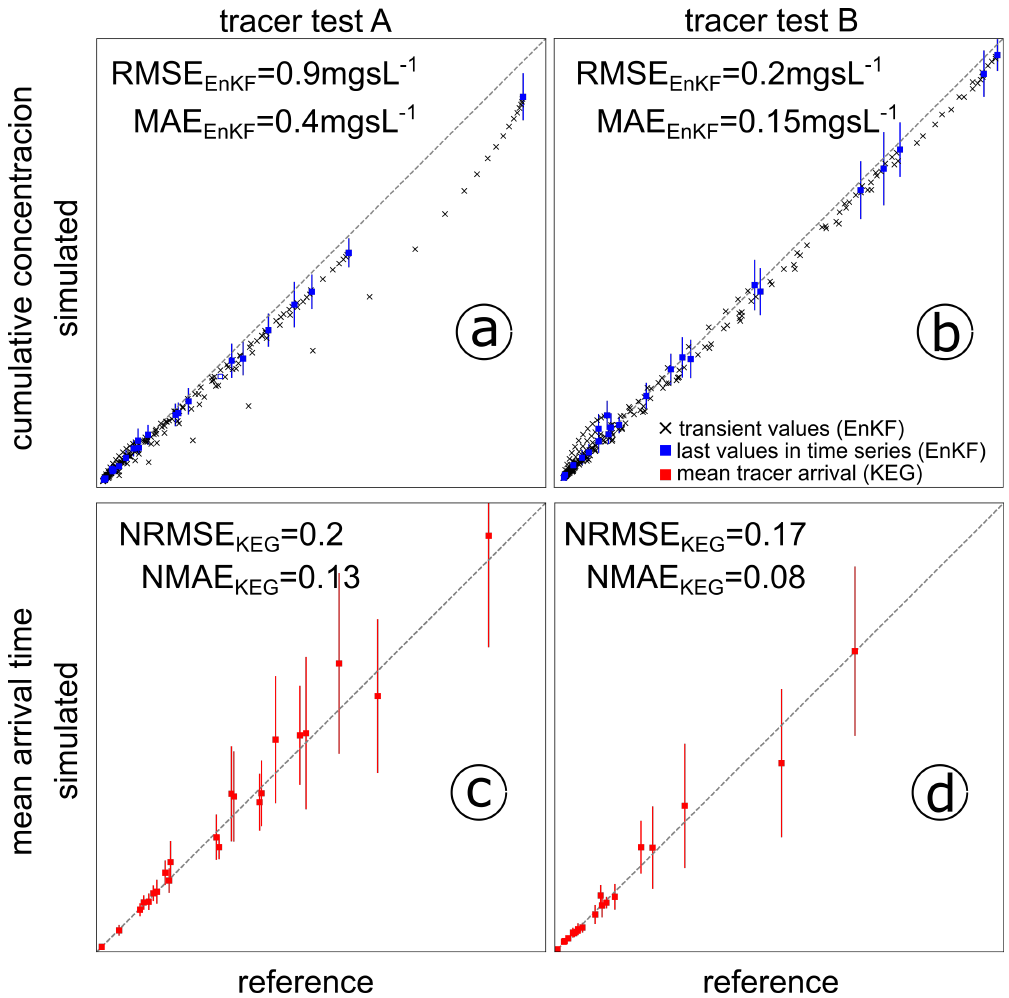
Figure 8. Calibration plot for the assimilated data of tracer test A ( a , c ) and tracer test B ( b , d ). Cumulative concentrations were assimilated with the EnK (black crosses, a , b ). Blue squares correspond to the last assimilation time-step with the EnKF. Mean tracer arrival times were used with the KEG (red squares, c , d ). RMSE: root mean squared error. MAE: mean absolute error. NRMSE and NMAE: RMSE and MAE normalized by the difference between maximum and minimum